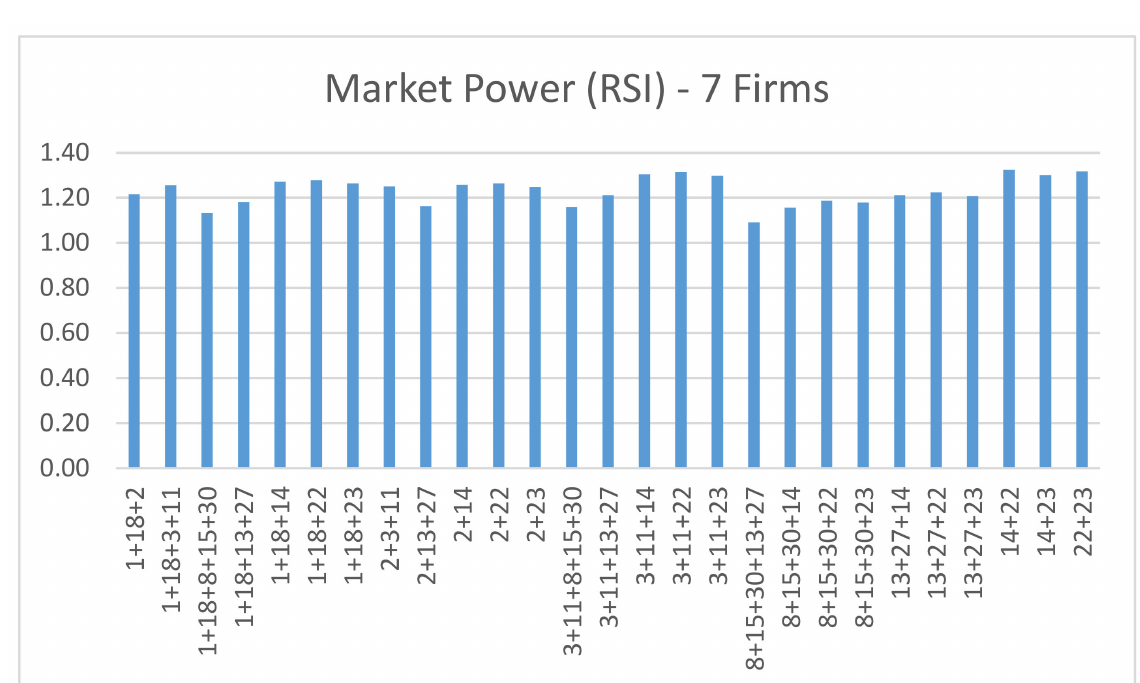
Figure 9. RSI for 8 firms’ setting (PC).